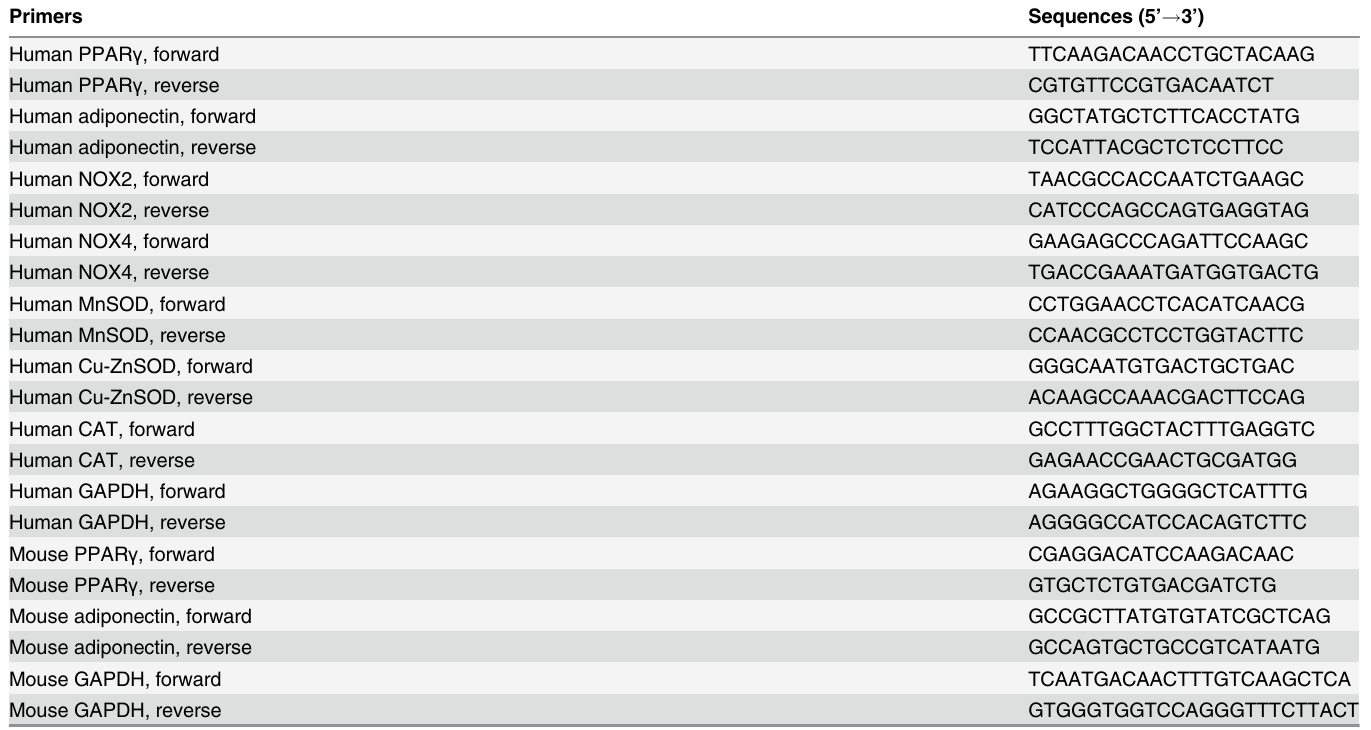
Table 1. Sequences of primers used for